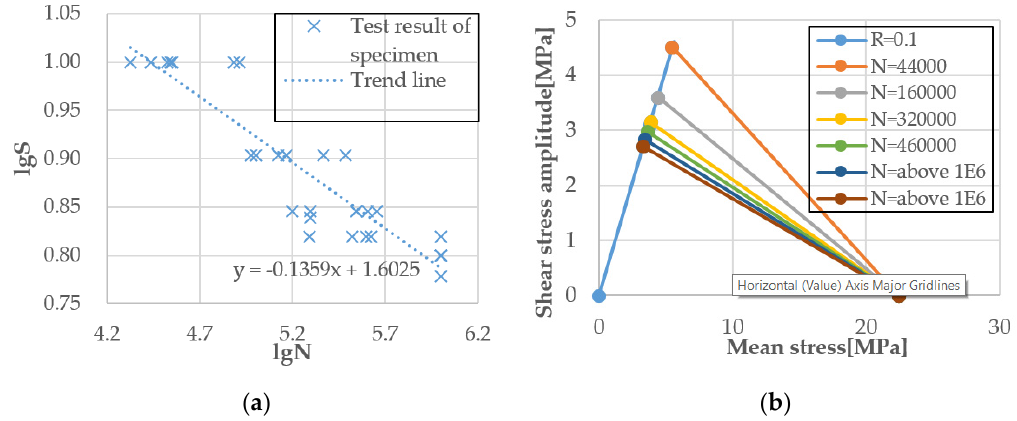
Figure 7. Test results of shear fatigue properties of the adhesive: ( a ) S–N curve of the shear property of the adhesive; ( b ) Shear fatigue in the constant-amplitude life diagram.